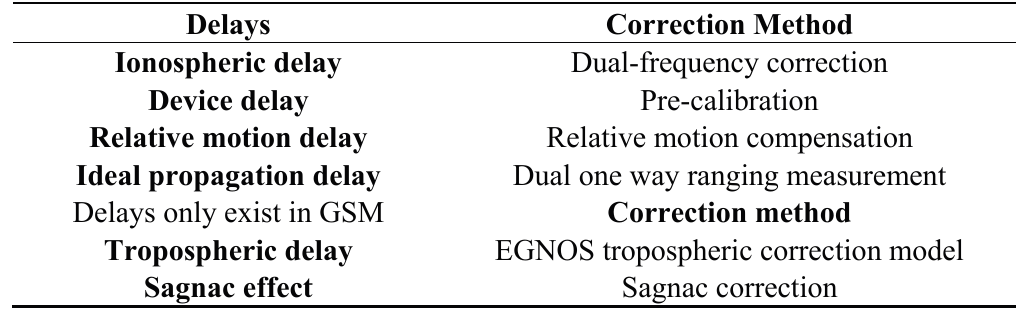
Figure 7. Schematic of the proposed clock adjustment algorithms on a slave satellite. Table 2. Different delays and corresponding correction